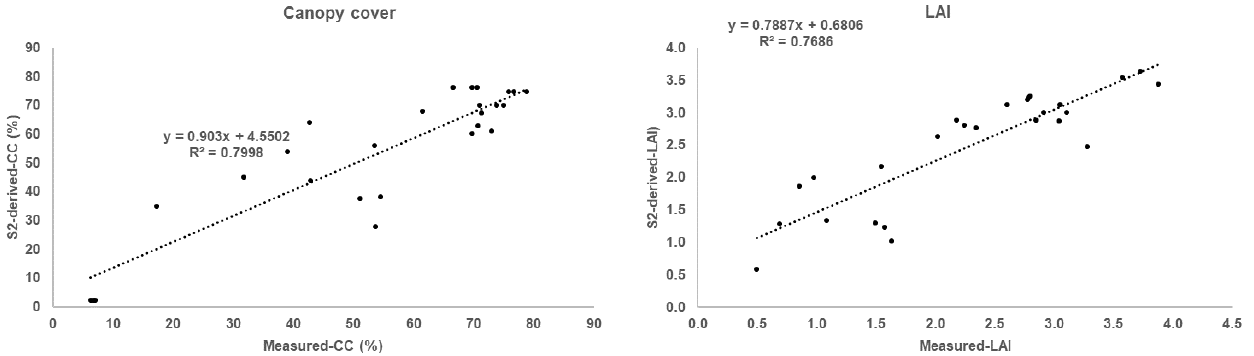
Figure 3. Regression between Sentinel 2 derived indices and measured LAI and CC.